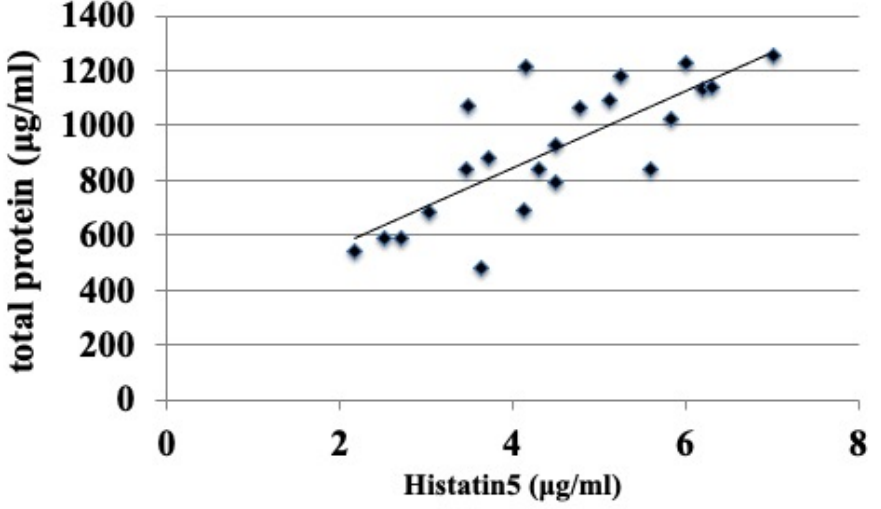
Figure 5. Correlation with histatin 5 and total salivary protein concentration in normal (N-2) subjects. The N-2 groups were normal (N-2) subjects over 40 years of age. Each rhombus is the histatin 5 concentration relative to the salivary protein concentration in N-2 groups. The N (normal) groups were subdivided according to age: normal (N-2) subjects over 40 years of age as shown in Table 1. The line yielded by a linear regression is plotted on the graph.